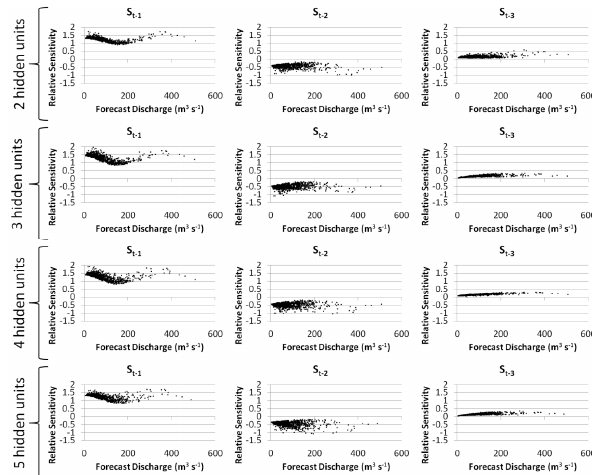
Fig. 10. Global–local relative sensitivity plots for all candidate models in Scenario A: calibration data.